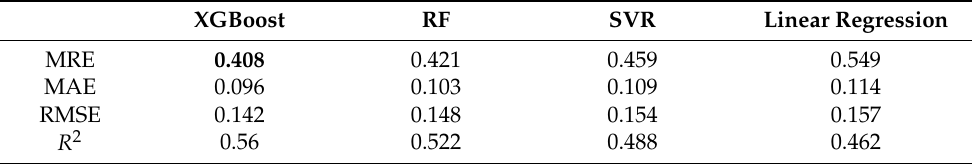
Table 5. Five environmental factors used for